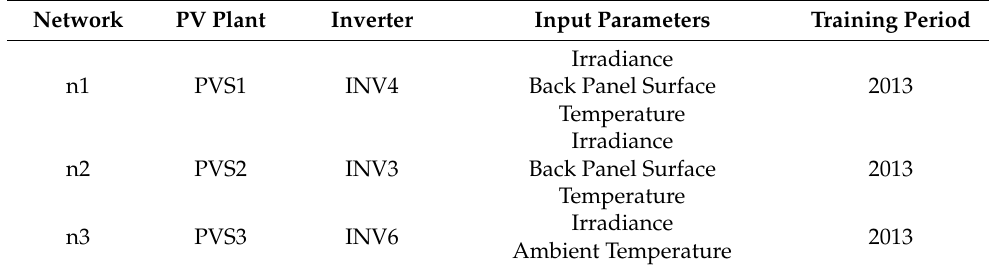
Table 2. Characteristics of the three FF ANNs and their respective PV systems. Network PV Plant Inverter Input Parameters Training Period n1 PVS1 INV4